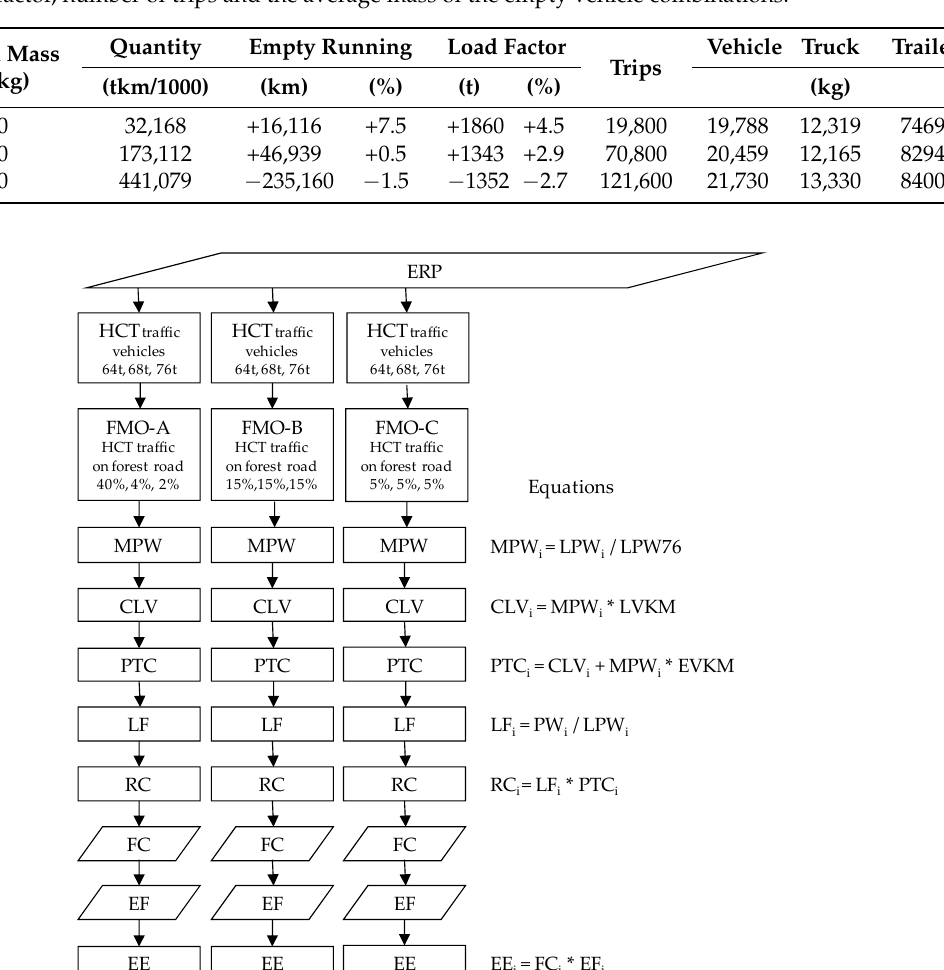
Figure 8. Flowchart of the energy efficiency analysis of the synchronized transportation system: ERP = enterprise resource planning data, HCT = 64, 68 and 76 t, FMO = fleet-management option, MPW = legal maximum payload weight (LPW) ratios of HCT with legal maximum payload weight of LPW76, CLV = change in total laden-vehicle-kilometres (LVKM) with legal maximum loads, PTC = potential total change in empty-vehicle-kilometres (EVKM) and laden-vehicle-kilometres with legal maximum loads, LF = load factor ratios of HCT between payload weights (PW) and legal maximum loads (LPW), RC = reduced total change with different load factors for mass-constraint loads, FC = fuel consumption, EF = energy factors and EE = energy efficiency: i = 1,2,3; 1 = 64 t, 2 = 68 t, 3 = 76 t.